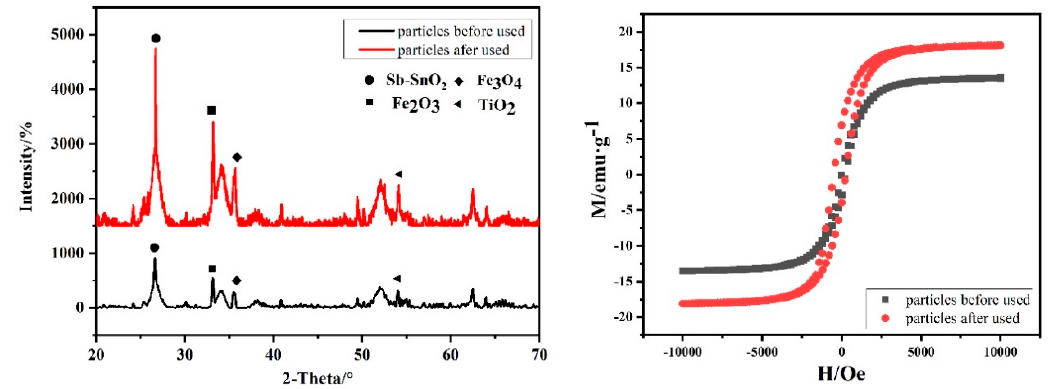
Figure 9. XRD patterns ( a ) and magnetization curves ( b ) of magnetic particles before and after electrolysis. Table 3. The surface element content of magnetic particles before and after electrolysis.